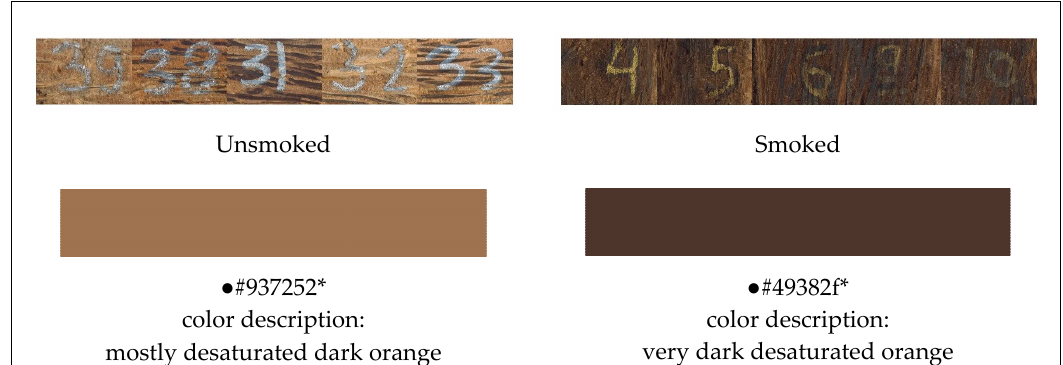
Figure 5. Discoloration of unsmoked and smoked specimens. * Remarks: the color description defined by ColorHexa [24].